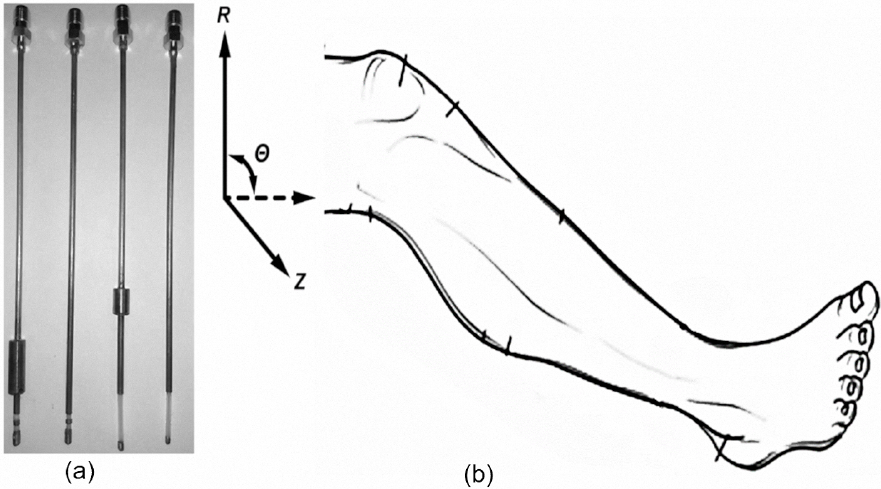
Figure 1. Micro-coaxial antennas and description of the displacements that the stereotactic positioning system must cover. ( a ) Example of four different micro-coaxial antennas designed to treat bone tumors [27], ( b ) axis convention for the stereotactic positioning system (Z-axis, Theta-axis, and R-axis) referred to the human